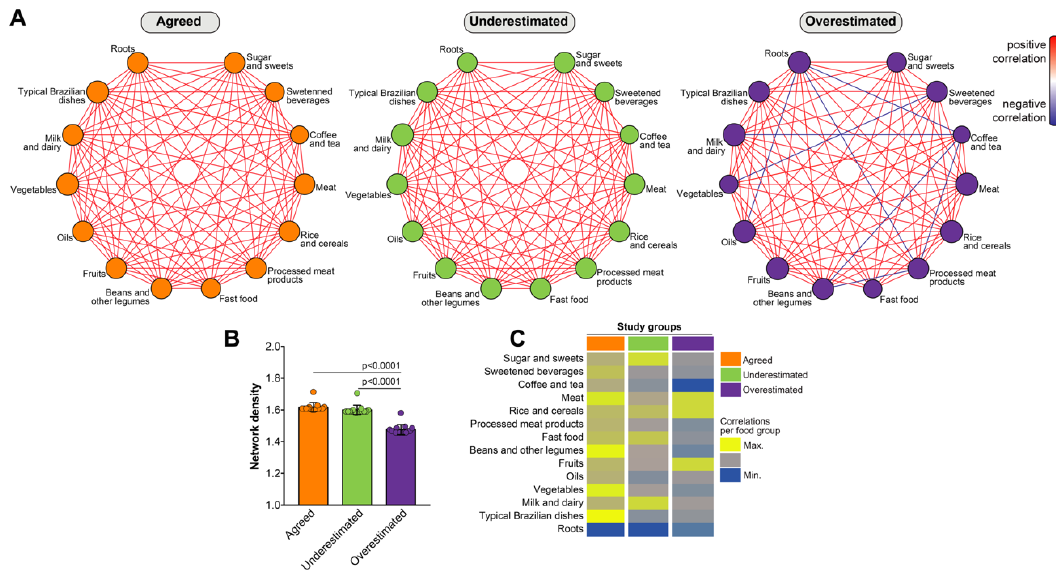
Figure 4. Network analysis of food consumption reveals negative correlations in individuals who overestimated their weight. ( A ) Spearman correlation matrices were designed for each study subgroup. Each matrix was submitted to 100 × bootstrap. Correlations with adjusted p -values < 0.05, with rho(r) values > ± 0.5 and which persisted exhibiting such values significant in at least 50% of the bootstraps were included in this analysis. ( B ) The network density, denoting the number of correlations (see Methods for details), was compared between using the Kruskal–Wallis test with Dunn’s multiple comparisons post-test. ( C ) Node analysis illustrate the number of correlations for each food group in the distinct subcategories of DMPW.